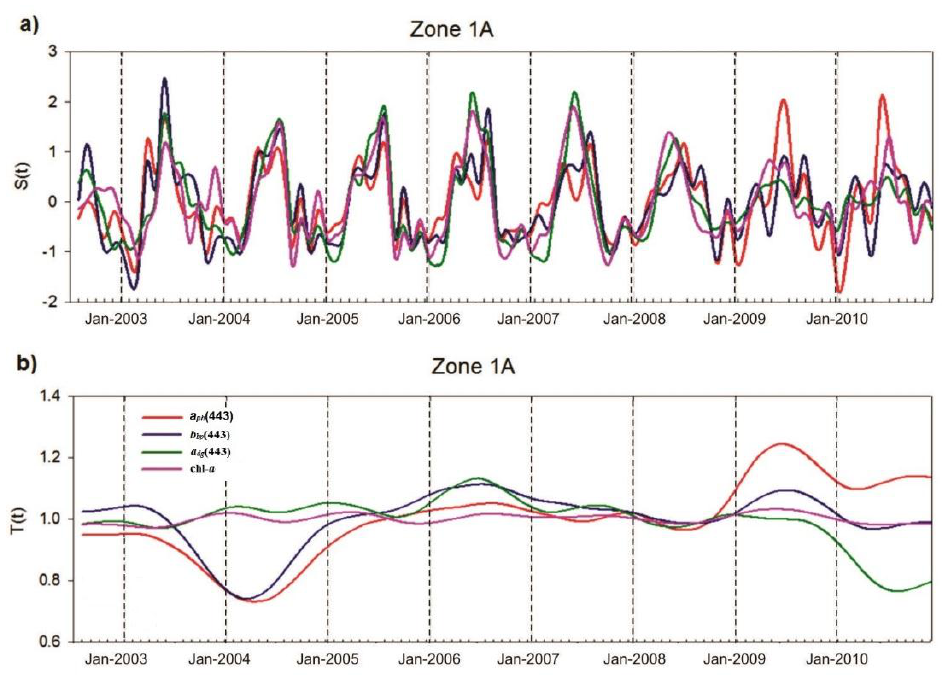
Figure 6. Seasonal Relative contribution of the total variance of the IOPs signal. In the left column is represented the seasonal component 2 ( ) p of the Census X-11 temporal decomposition analysis (in %). component 2 ( ) T